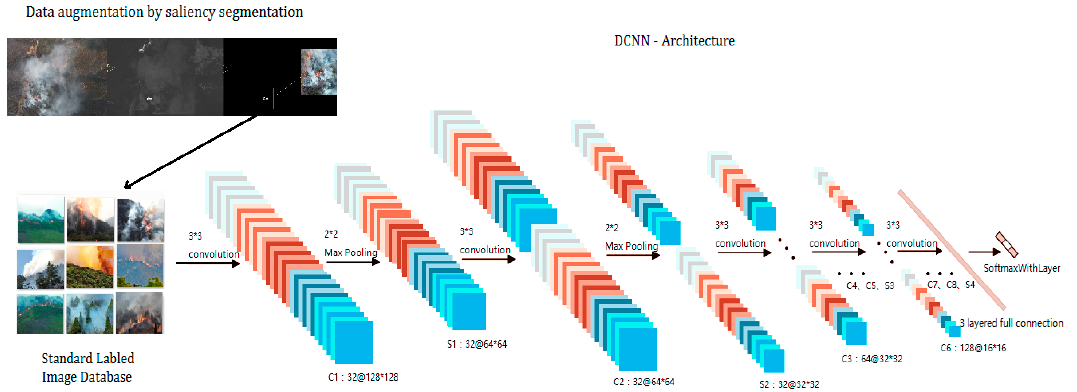
Figure 5. The overall architecture of ‘Fire_Net’. Table 2 . Definition of layers in ‘Fire_Net’.